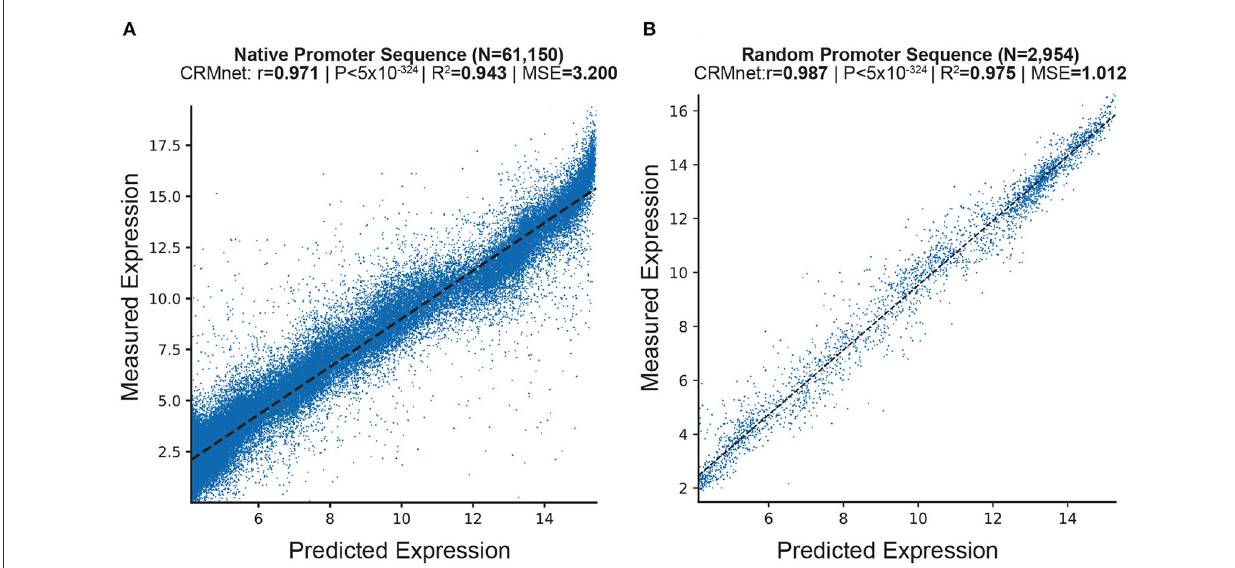
FIGURE2 Prediction of expression from yeast native sequences from CRMnet. CRMnet tested on (A) native promoter sequences; and (B) random promoter sequences. The y-axes represent measured expression levels, while the x-axes represent predicted expression levels. As a benchmark, the model performance metrics of the Pearson r -value, associated two-tailed p -values, R-square, and MSE for the transformer model from Vaishnav et al. (2022) showed: (A) : r = 0.963, P < 5 × 10 − 324 , R 2 = 0.927, MSE = 3.965; (B) : r = 0.978, P < 5 × 10 − 324 , R 2 = 0.95, MSE = 1.425.